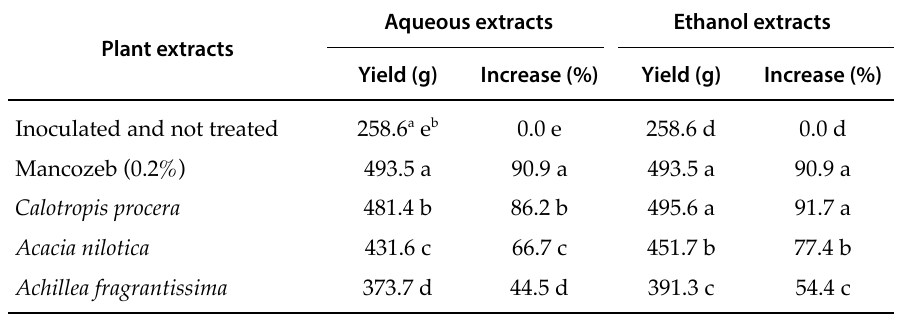
Table 5. Mean tomato fruit yields from field-grown plants treated with fungicide, or aqueous of ethanol extracts from three medicinal plants.*